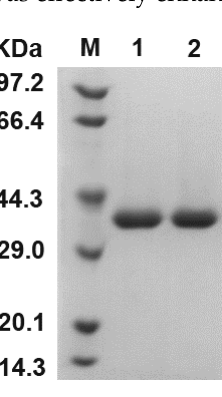
Figure 3. SDS-PAGE analysis of the purified WT and M5D mutant. Lane M is the molecular mass marker. Lanes 1 and 2 are the WT and M5D mutants, respectively. Table 3. Thermostability and specific activity of the WT and M5D